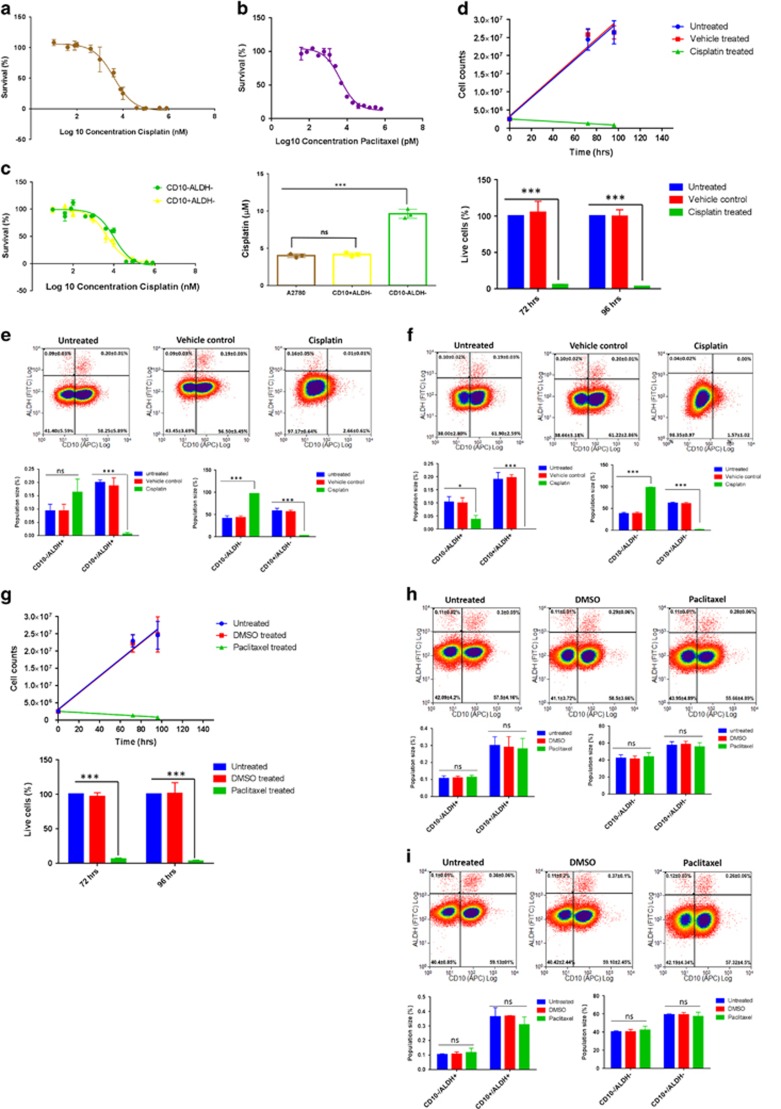
CD10−/ALDH− CSCs are the chemoresistant component of the CD10/ALDH ovCSC network. Dose–response analysis was used to calculate IC50s of (a) 4.1±0.2 μM for cisplatin, n=3; and (b) 4.6±1.0 nM for paclitaxel, n=3 for A2780 cells. To elucidate the relationship between the CD10/ALDH network and chemoresistance, A2780 cells were treated with cisplatin for (d and e) 72 and (f) 96 h, and the effect on the four populations was then assessed via flow cytometry (e and f). Although untreated and DMSO vehicle-treated control cells were unaffected (d–f), cisplatin treatment resulted in a substantial cell death (d). Flow cytometry indicated that this was due to substantial cell death in the CD10+/ALDH+, CD10−/ALDH+ and CD10+/ALDH− populations (e and f). In contrast, a proportional increase in the size of the CD10−/ALDH− population was observed (e and f). This was confirmed by statistical analysis (bar charts, unpaired Student’s t-test, mean population size (%)±S.D. of n=3, NS=not significant, ***P-value<0.0001). Notably, by 96 h (d and f) the apex CD10+/ALDH+ CSC has been depleted to the point of being undetectable. Although the CD10+/ALDH+ and CD10−/ALDH+ populations were too small to facilitate toxicology assays, cisplatin dose–response curves (c: IC50, left panel; statistical analysis, right panel) showed that the CD10−/ALDH− CSCs (IC50=9.6±0.6 μM; n=3) were proportionally cisplatin resistant and the CD10+/ALDH− CSCs proportionally cisplatin sensitive (IC50=4.2±0.3 μM; n=3). In contrast, A2780 cells were found to have a much lower tolerance for paclitaxel (b: IC50=4.6±1.0 nM). (h) Seventy-two and (i) 96 h 4.6 nM paclitaxel treatment was found to result in substantial cell death (g), which affected all four populations uniformly. Together, these data indicate that CD10−/ALDH− CSCs are the sole cisplatin-resistant component of this ovCSC network. As these cells had not been exposed to cisplatin previously, this is deemed to be inherent chemoresistance. However, these data indicate that the entire ovCSC network is highly sensitive to paclitaxel